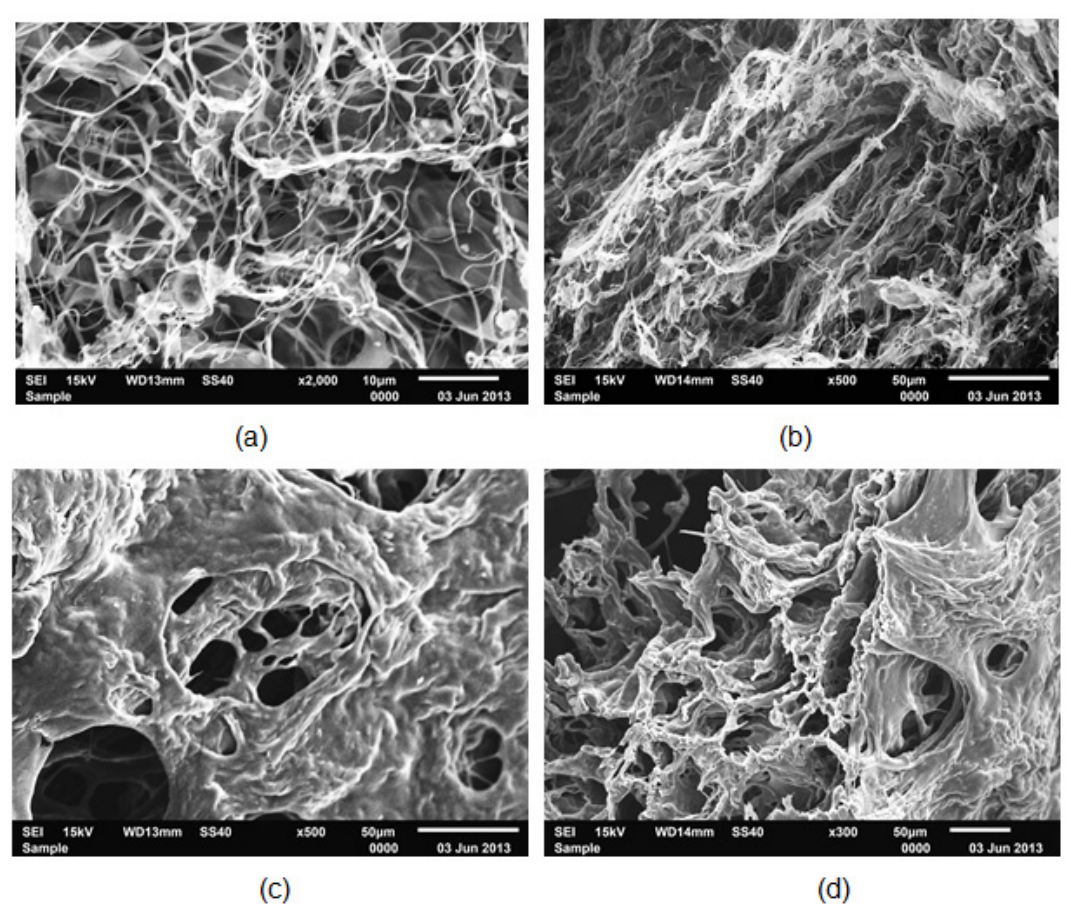
Figure 1. SEM surface images of pure collagen (a) and BC/COL hydrogel (c). SEM crosssection images of pure collagen (b) and BC/COL hydrogel